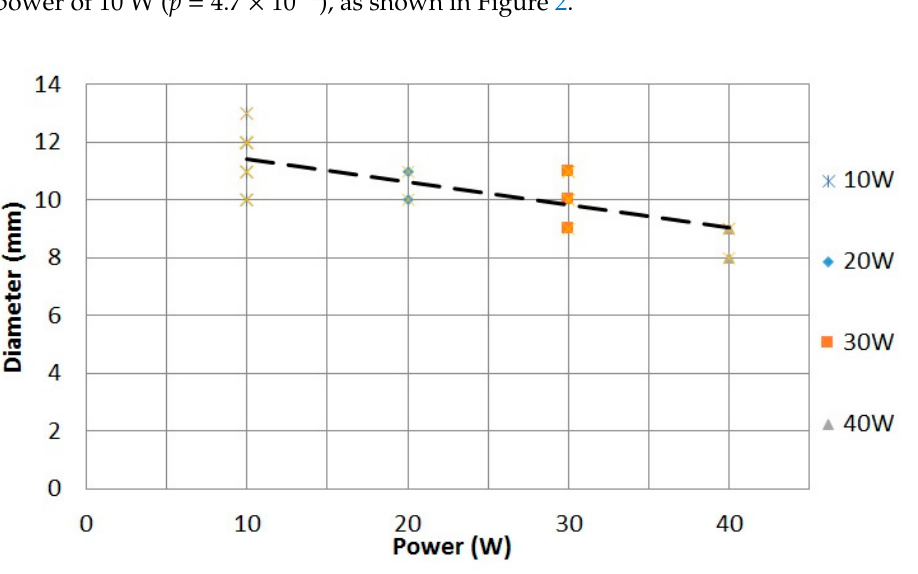
Figure 2. Macroscopic ablated area diameters (millimeters) and powers (10, 20, 30, 40 W). Maximum size of macroscopic ablated area after radiofrequency ablation was obtained at 10 W.